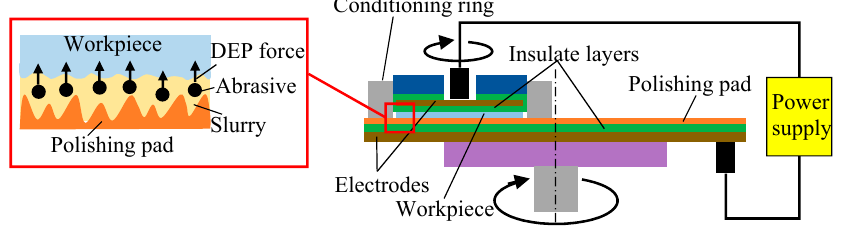
Figure 1. Mechanism and apparatus of DEPP.